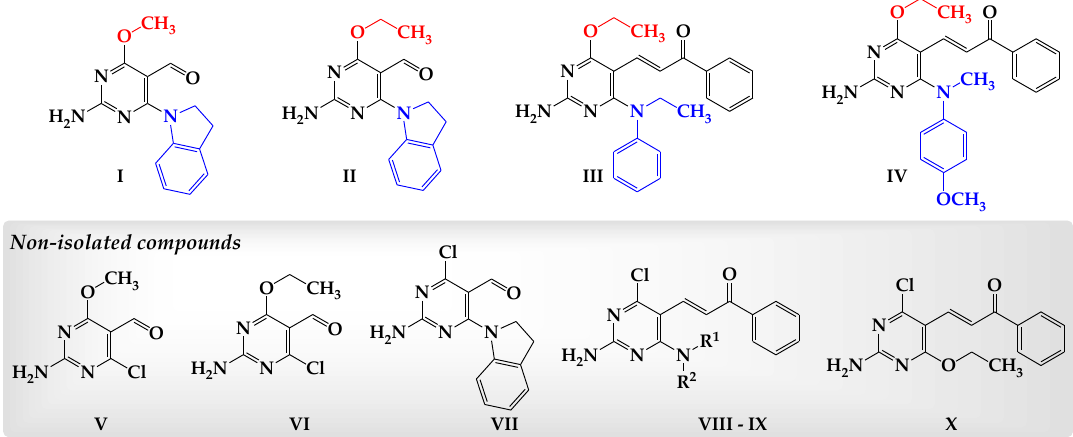
Figure 1. Isolated ( I – IV ) and expected ( V – X ) compounds. The 2-amino-4,6-dichloropyrimidine-5-carbaldehyde is a symmetric compound in which all positions, except for the position at C –5, are α and/or γ to a nitrogen inside the ring. Consequently, when undergoing S N Ar amination reactions, the second nitrogen atom of the ring decreases electron density and contributes to the stabilization of anionic intermediates, increasing